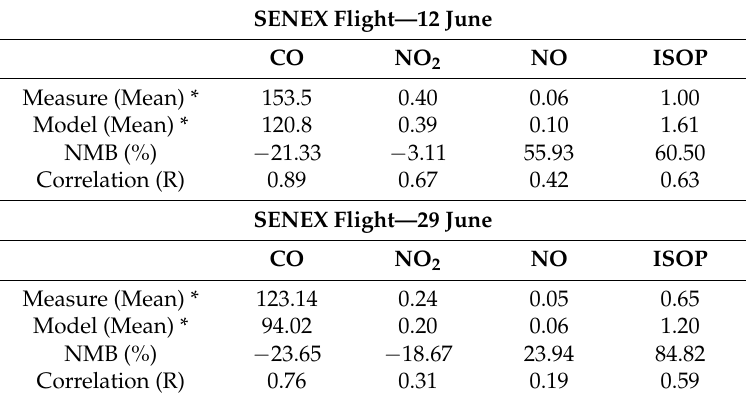
Figure 4. GEOS-Chem-predicted O 3 (red line) compared to instantaneous measurements from NOAA P3 flights (black line) on ( a ) 12 June 2013 and ( b ) 29 June 2013. Table 1. GEOS-Chem evaluation of O 3 precursor species (CO, NO x , ISOP) using measurement data from NOAA P3 flights during SENEX on 12 and 29 June 2013.